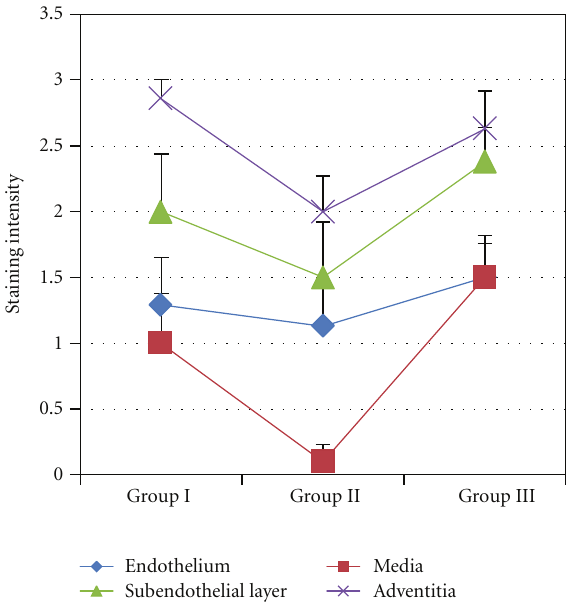
the immunohistochemical staining of Bax and NF-kappaB).